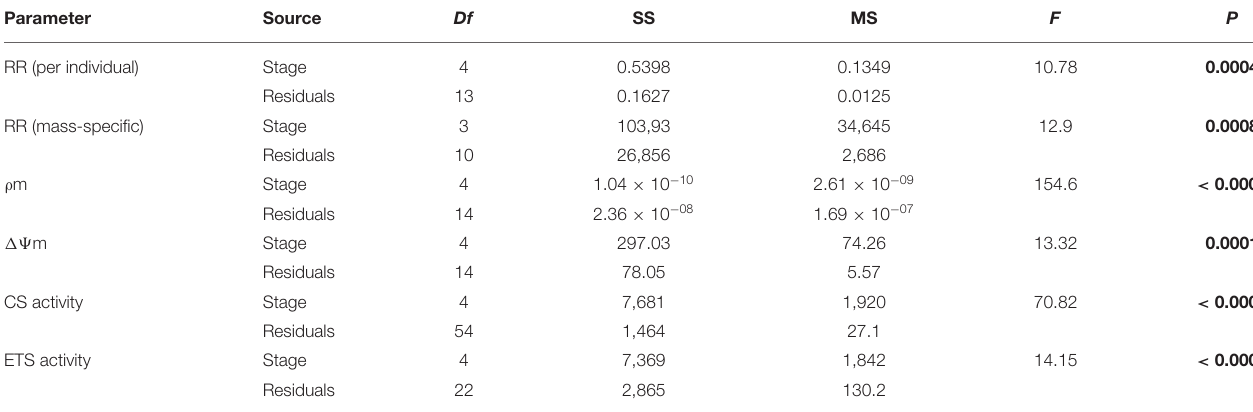
TABLE 1 | One-Way ANOVA evaluating the effect of the developmental stage under basal conditions on respiration rates (RR), mitochondrial density ( ρ m), mitochondrial membrane potential ( 19 m), citrate synthase activity (CS), electron transport chain activity (ETS), and ETS:CS ratio (robust ANOVA) throughout larval development and in early juveniles from the scallop Argopecten purpuratus